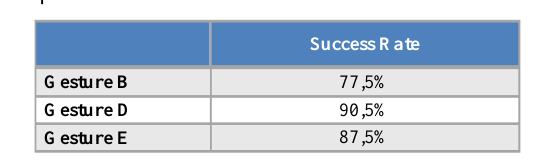
Table 3. Success rate for the recognition of singular gestures with a manually selected